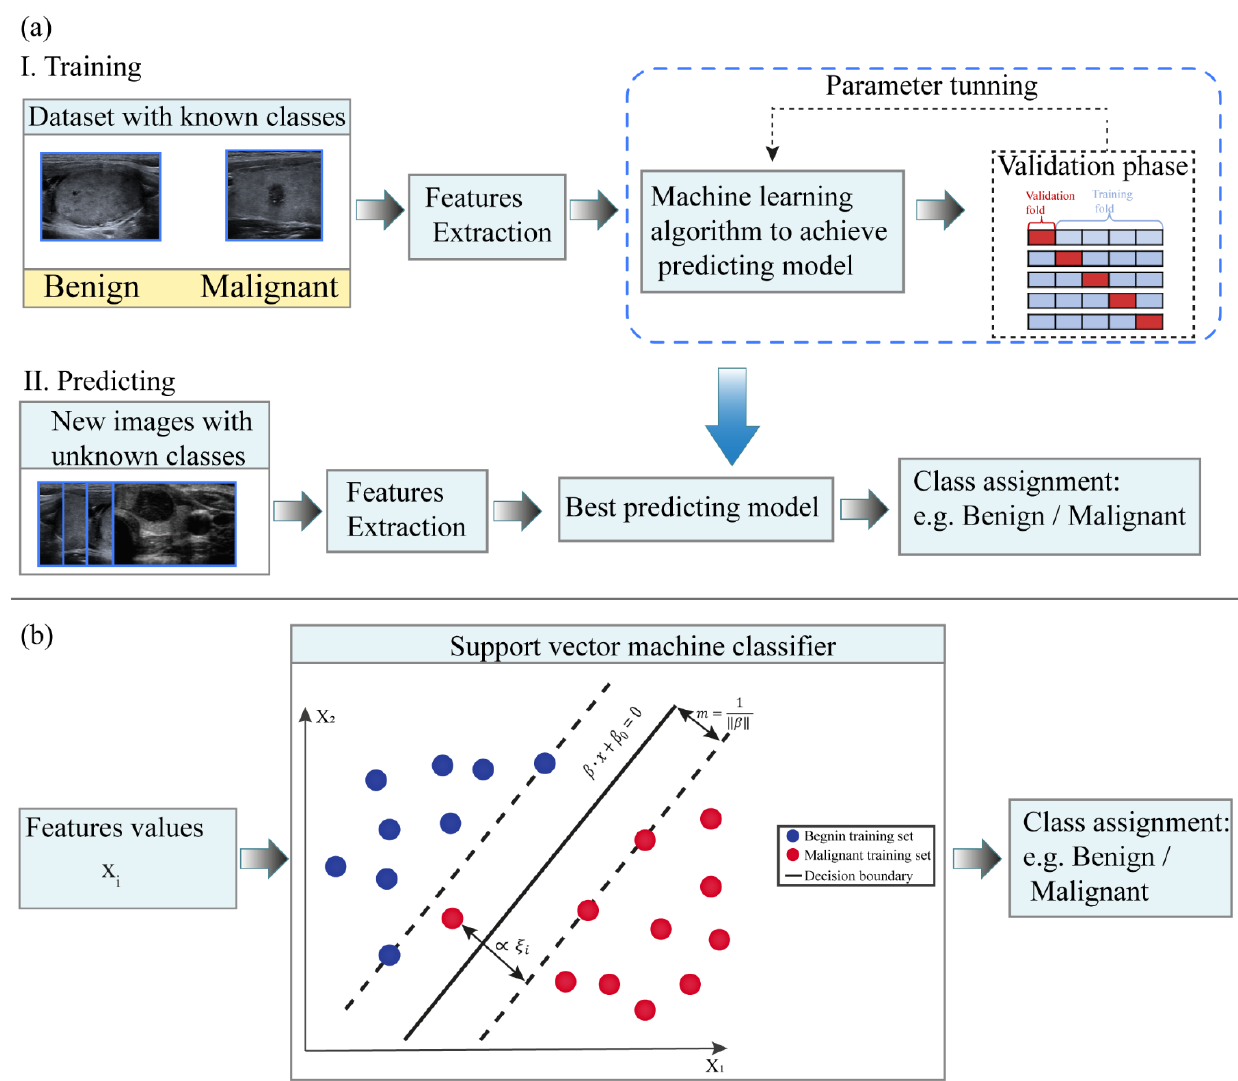
Figure 1. ( a ) Schematic flowchart of the machine learning model implementation and application for medical images classification purposes. ( b ) Example of the support vector machine (SVM) classification with a hyperplane that maximizes the separating margin m between the two classes.